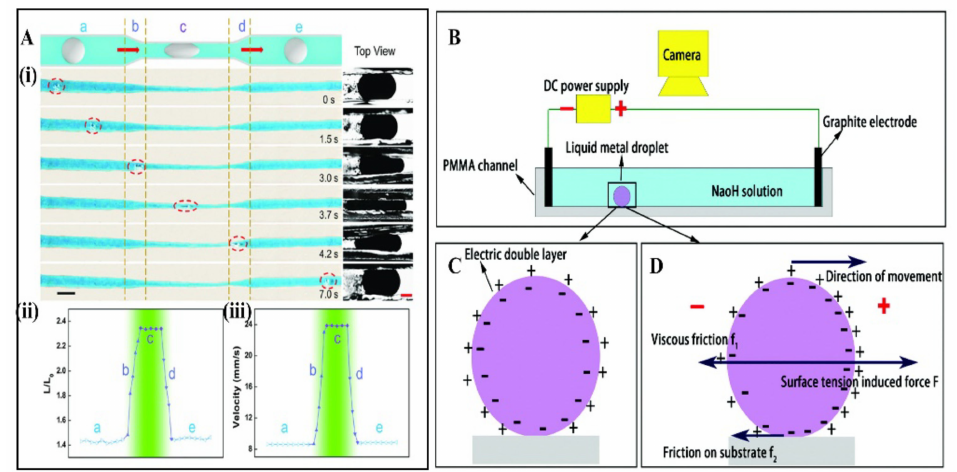
Figure 12. Electric-field-propelled MLMTs. ( A ) MLMTs deform and speed up in confining channels under a 30 V DC electric field. ( i ) A schematic illustration of the movement and deformation of MLMTs in a channel with different section widths. ( ii ) The relationship of the deformation degree (L/L 0 ) of MLMTs and its position in the channels. ( iii ) The instantaneous velocity of MLMTs [41]. ( B ) The schematic representation of the experimental setup and the CEW effect [105]. ( C ) EDL distribution state without an external electric field [105]. ( D ) EDL distribution state under an external electric field